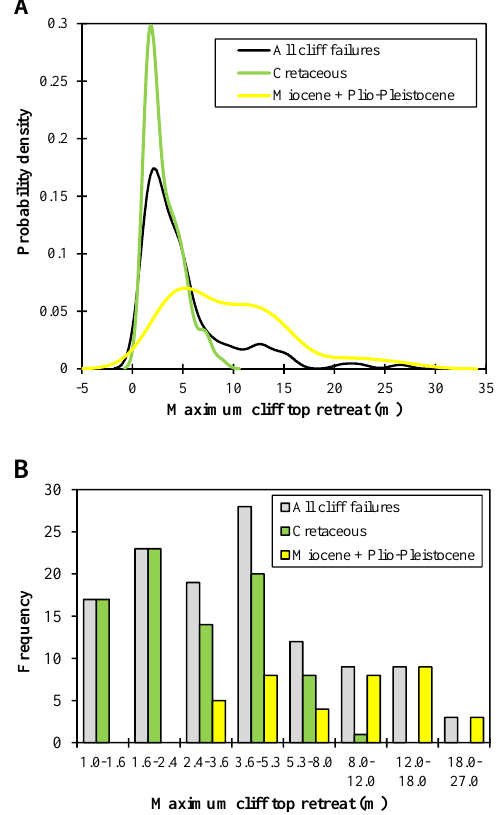
Fig. 3. (A) Probability density of maximum cliff top retreat, with Figure 3. A) Probability density of maximum cliff top retreat, with probability densities 3 probability densities computed with a kernel density estimation computed with a kernel density estimation (Brunetti et al., 2009) using a MS EXCEL add-in 4 (Brunetti et al., 2009) using an MS EXCEL add-in (Ellison, 2002). (B) Histogram of maximum cliff top retreat caused by cliff failures (Ellison, 2002). B) Histogram of maximum cliff top retreat caused by cliff failures in 5 in Cretaceous, and Miocene plus Plio-Pleistocene formations. His- Cretaceous, and Miocene plus Plio-Pleistocene formations. Histogram class limits based on a 6 togram class limits based on a 1.6 × progression. 1.6x progression. 7